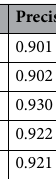
subsets is given in the relevant column of Table 3. We limit this procedure to the GData set, as it contains a larger number of subjects and, therefore, allows us more flexibility in generating appropriate subsets for testing. However, we believe that the fact that a model which was trained on the age-imbalanced SData set, generalises well on the age-corrected GData set, serves as adequate proof. Finally, this conclusion is also supported by the fact that using age as a PD predictor in the GData set, yields an AUC of ∼ 0.71 (with a 95% CI of 0.588–0.814), that is significantly less than the AUC of ∼ 0.87 achieved by the model.